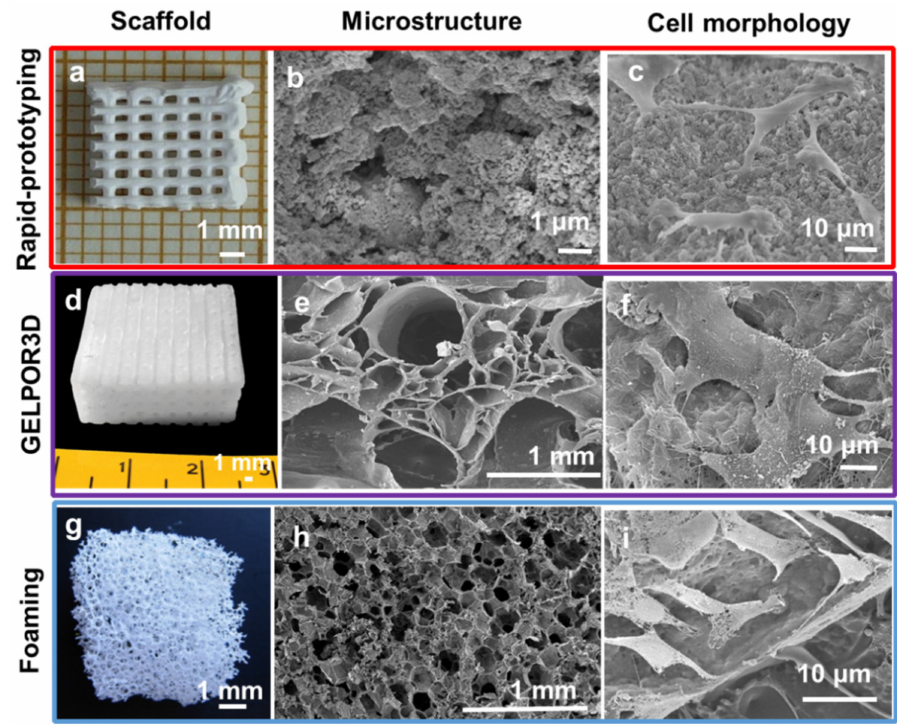
Figure 5. Photographs of HA-based scaffolds fabricated by three different methods ( a , d , g ); scanning electron micrographs showing the scaffold microstructure ( b , e , h ) and the morphology of osteoblast- like cells cultured onto the scaffolds ( c , f , i ). Photographs and SEM micrographs reproduced with permission from S á nchez-Salcedo et al. [60], J. Mater. Chem. B; published by Royal Society